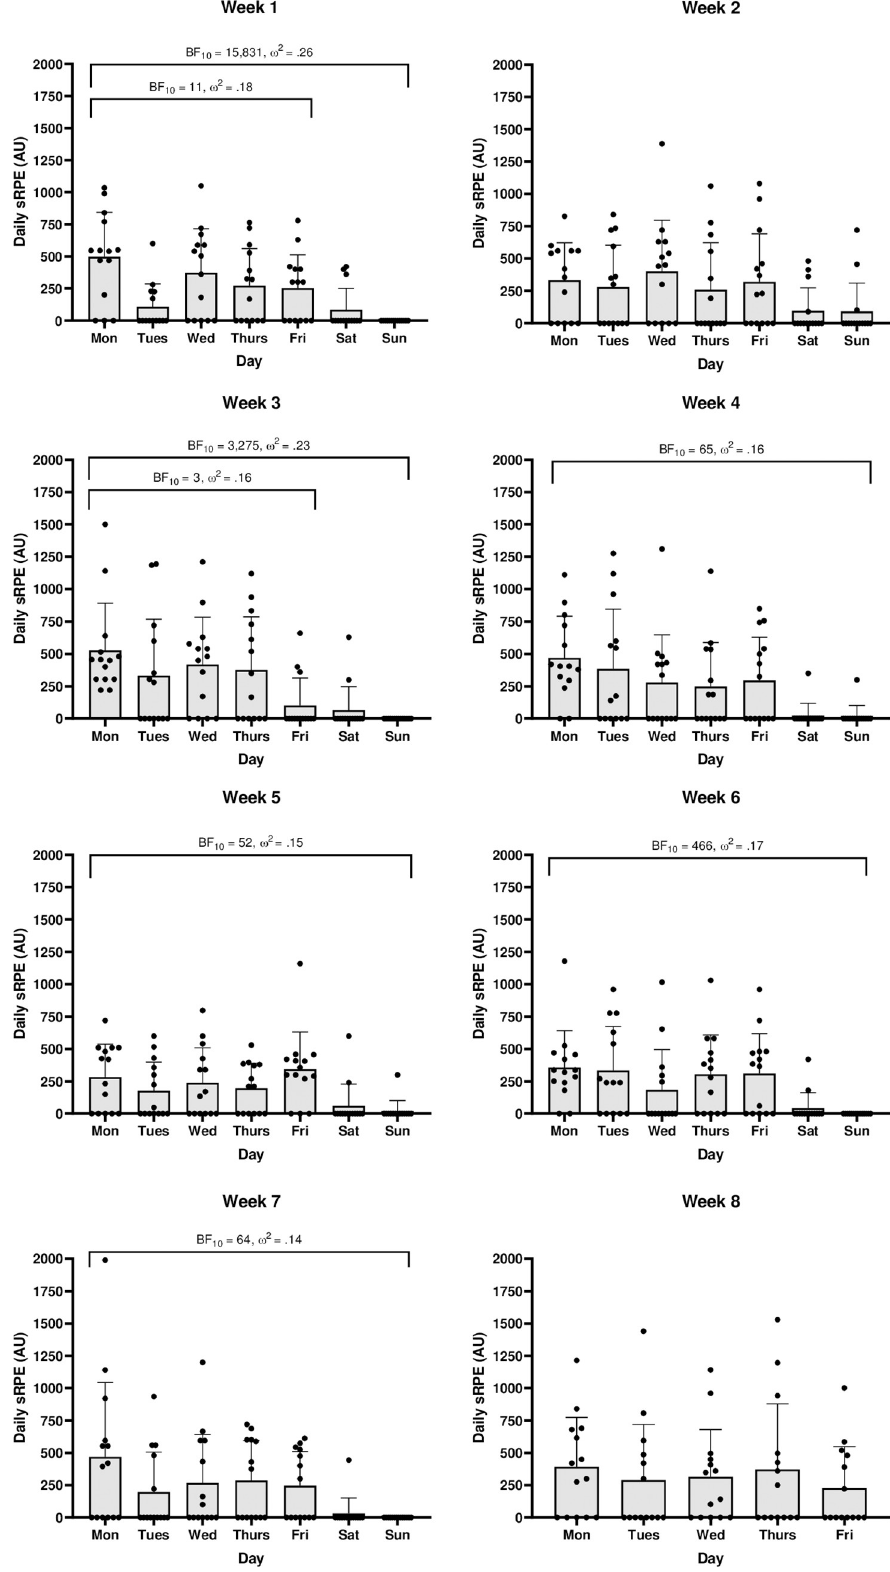
Fig 5. Within week sRPE (AU) comparisons. Black dots represent individual participants. Error bars = SD. https://doi.org/10.1371/journal.pone.0251266.g005 PLOS ONE | https://doi.org/10.1371/journal.pone.0251266 May 10,